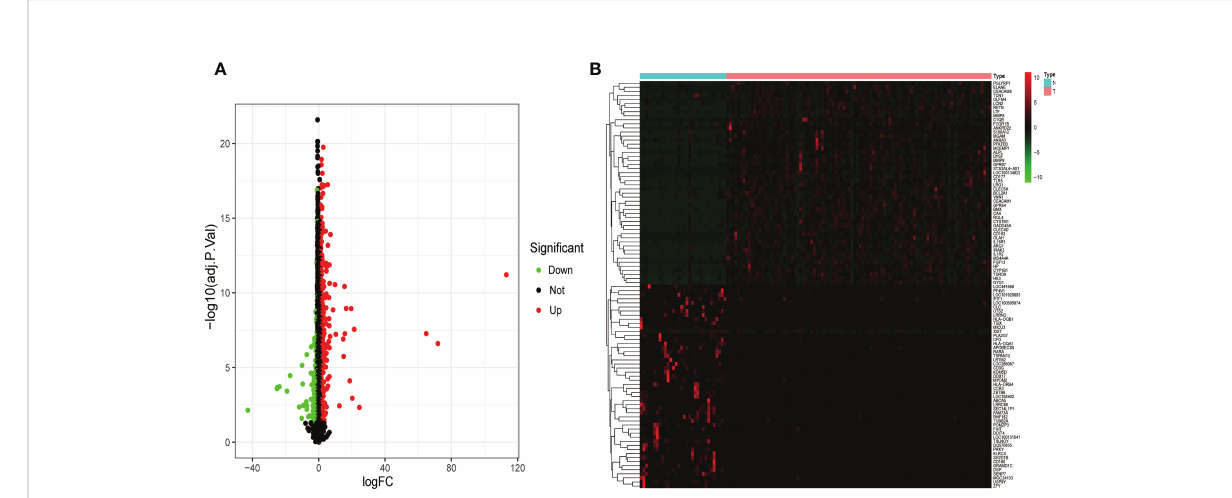
FIGURE 2 Identi fi cation of the DEGs in pediatric septic shock. (A) Volcano showed expression of DEGs between the pediatric septic shock and healthy cohort. (B) The heatmap showed the top 50 up-regulated DEGs and 50 down-regulated DEGs.